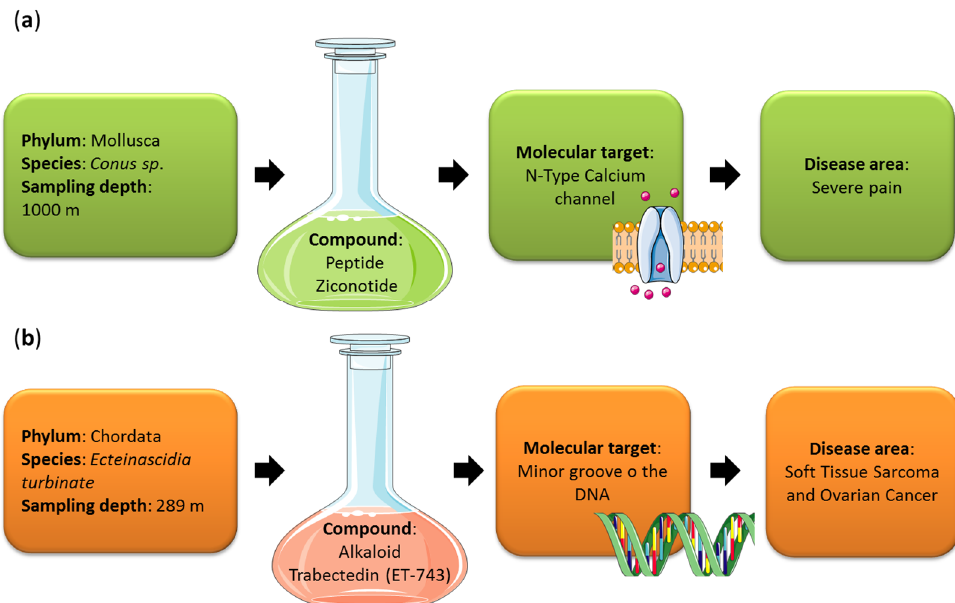
Figure 3. Two deep marine derived drugs are currently on the market: ( a ) Prialt ® and ( b ) Yondelis ® . The figure shows species and sampling depth from which the compounds have been isolated, their molecular targets and disease areas. ( a ) Ziconotide (Prialt ® ) was derived from the venom of a marine snail ( Conus sp.) and is used for the treatment of severe pain. ( b ) Trabectedin, ET-743 (Yondelis ® ), was derived from a marine tunicate Ecteinascidia turbinate and is used for the treatment of soft tissue sarcoma and ovarian cancer.